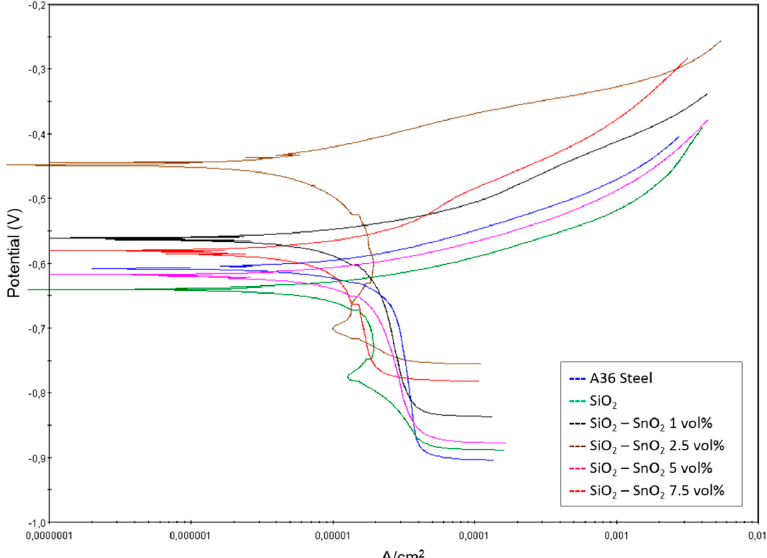
Figure 5. Polarization curves obtained in a 3 wt % NaCl solution for A36 steel with SiO 2 coatings in the absence and presence of SnO 2 nanoparticles.